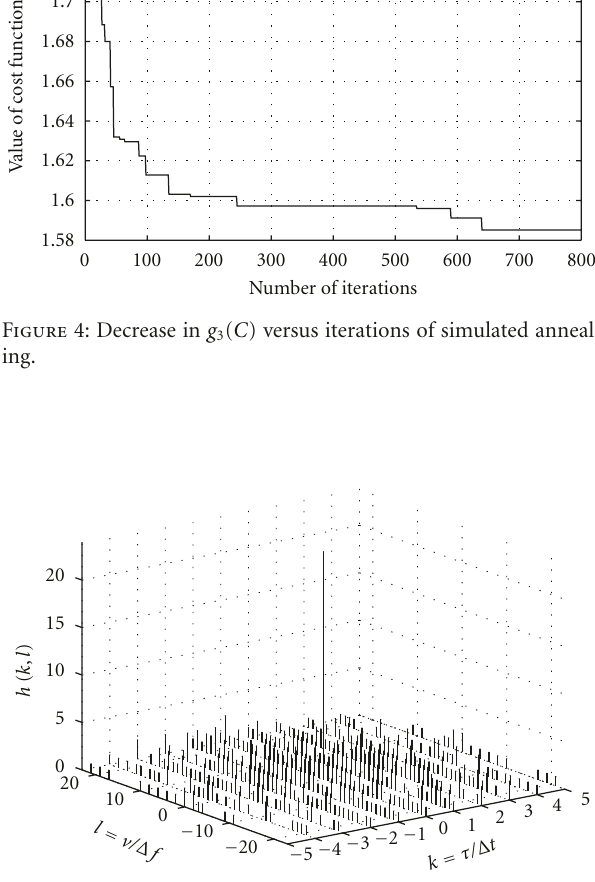
Figure 5: Plot of the hit-matrix of a code obtained from simulated annealing using g 3 ( C ).